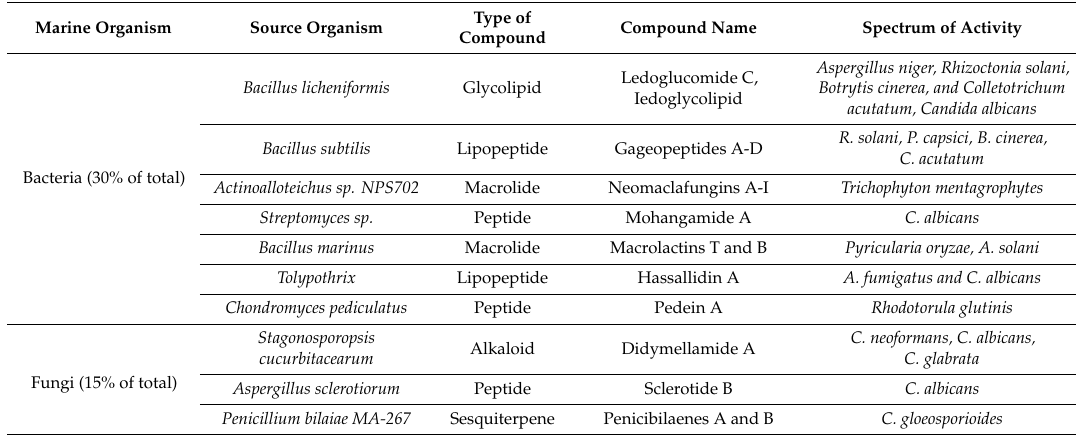
Table 4. Overview of antifungal natural compounds produced by marine organisms